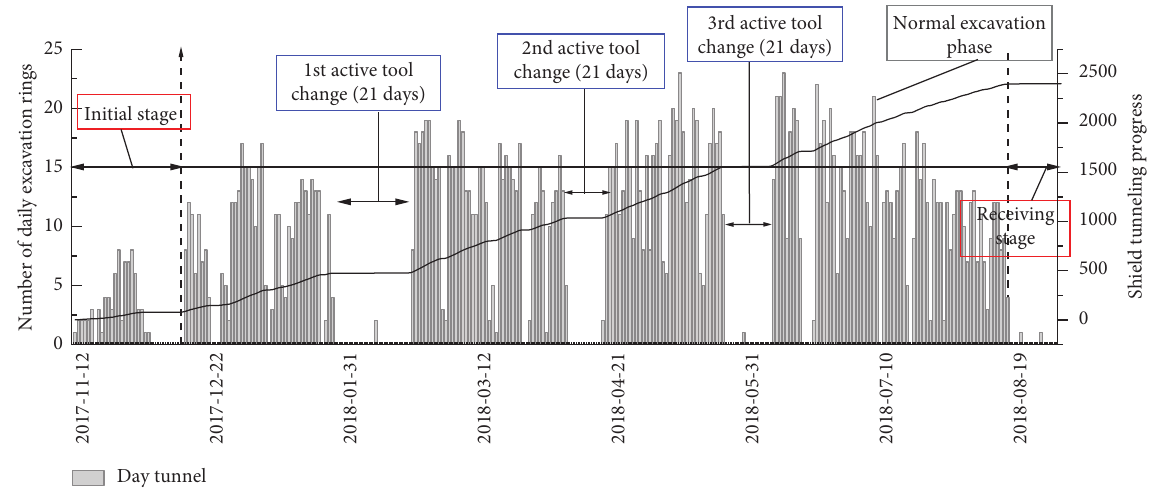
Figure 12: Construction schedule map of right line of interval.